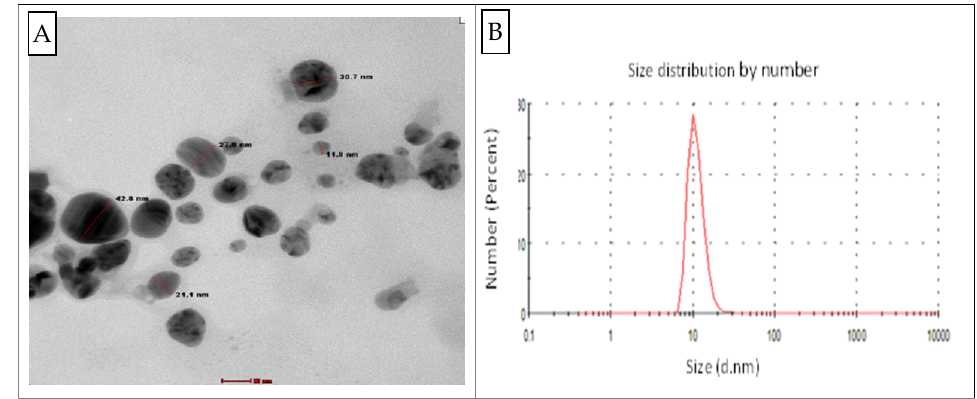
Figure 4. Transmission electron microscopy (TEM) micrograph of AgNPs produced by Streptomyces aizuneusis ( A ) and particle size distribution curve ( B ) .